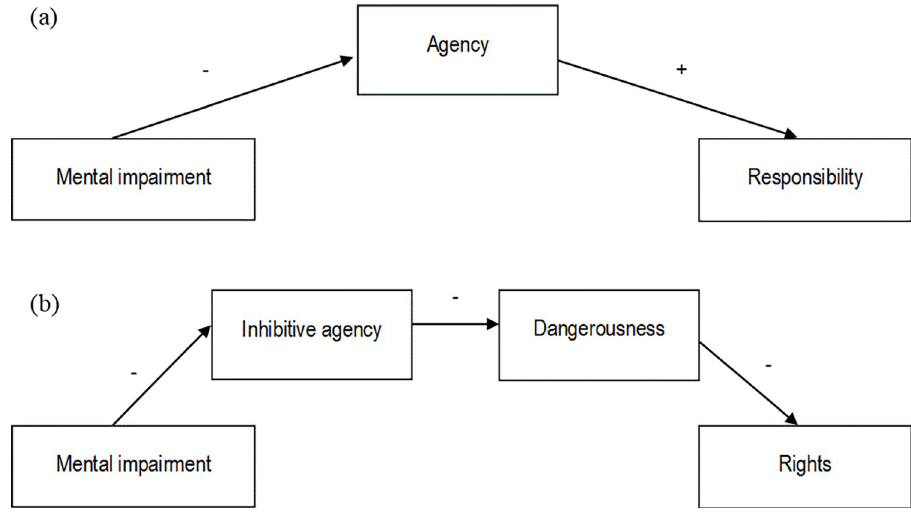
Fig 1. Models of the effects of using the defense of mental impairment on (a) responsibility; and (b) rights.